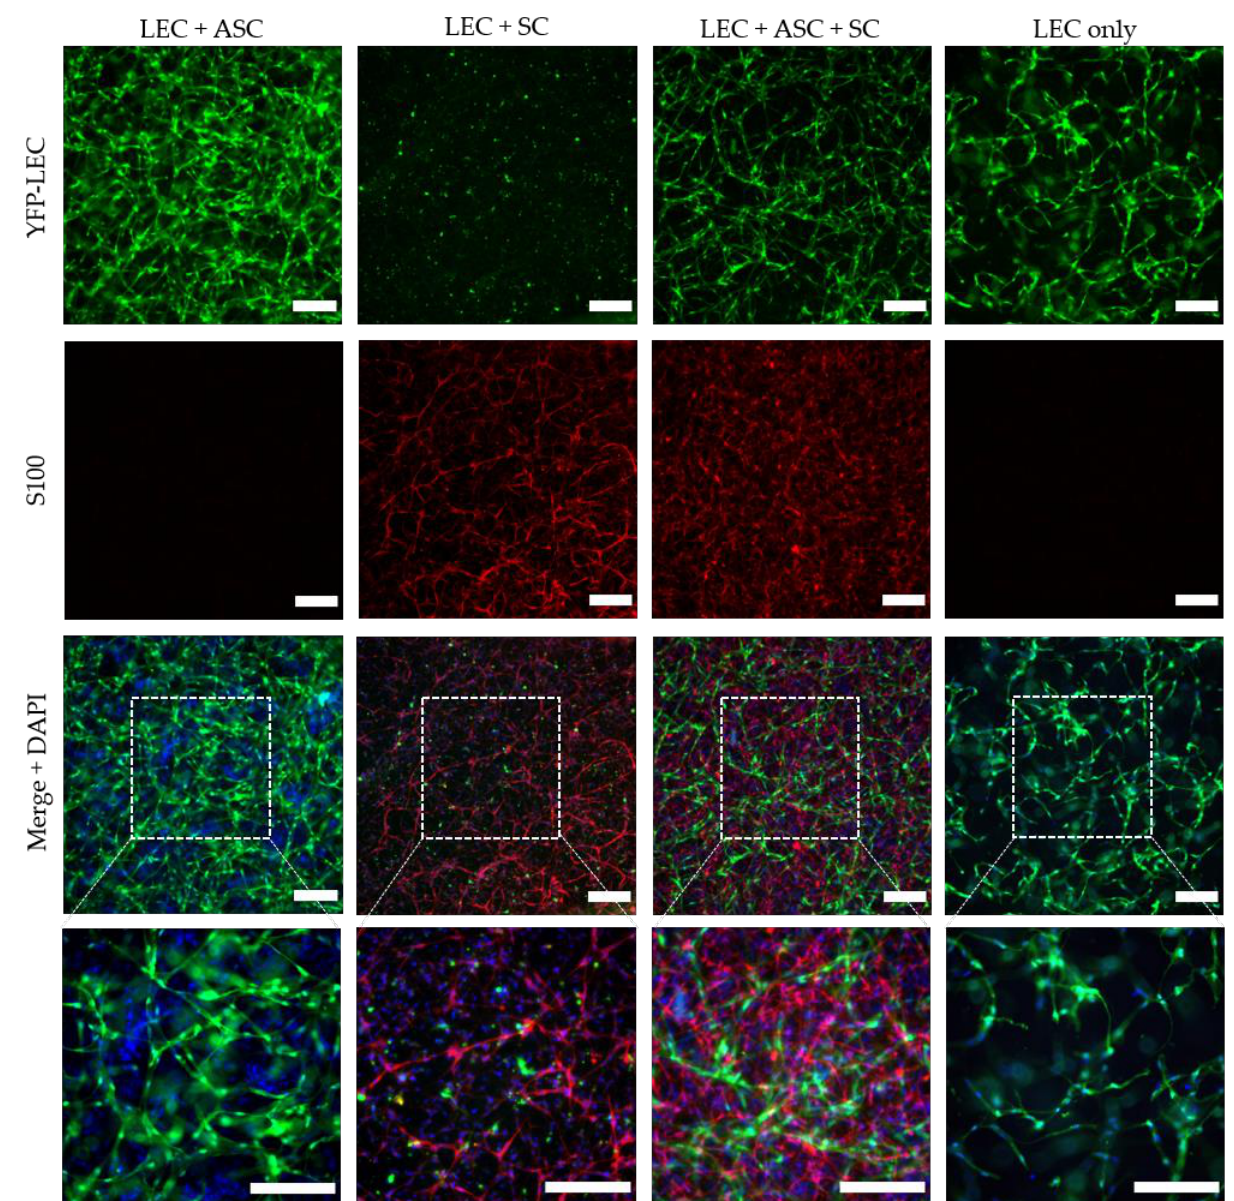
Figure 4. Lymphatic network formation is decreased in the presence of Schwann cells in 3D fibrin hydrogels. LECs formed elongated and interconnected networks when cultivated with ASCs as a supporting cell type (LEC + ASC). In a tri-culture of LECs, ASCs, and SCs, lymphatic vessel formation was less dense and interconnected (LEC + ASC + SC), whereas in the monoculture of LECs, only primitive tube-like structures were formed. In contrast, co-culture of only LECs and SCs inhib- ited the formation of lymphatic tubes. Green — YFP-LECs, red — SCs stained against S100, blue — cell nuclei. Scale bars = 200 µm.